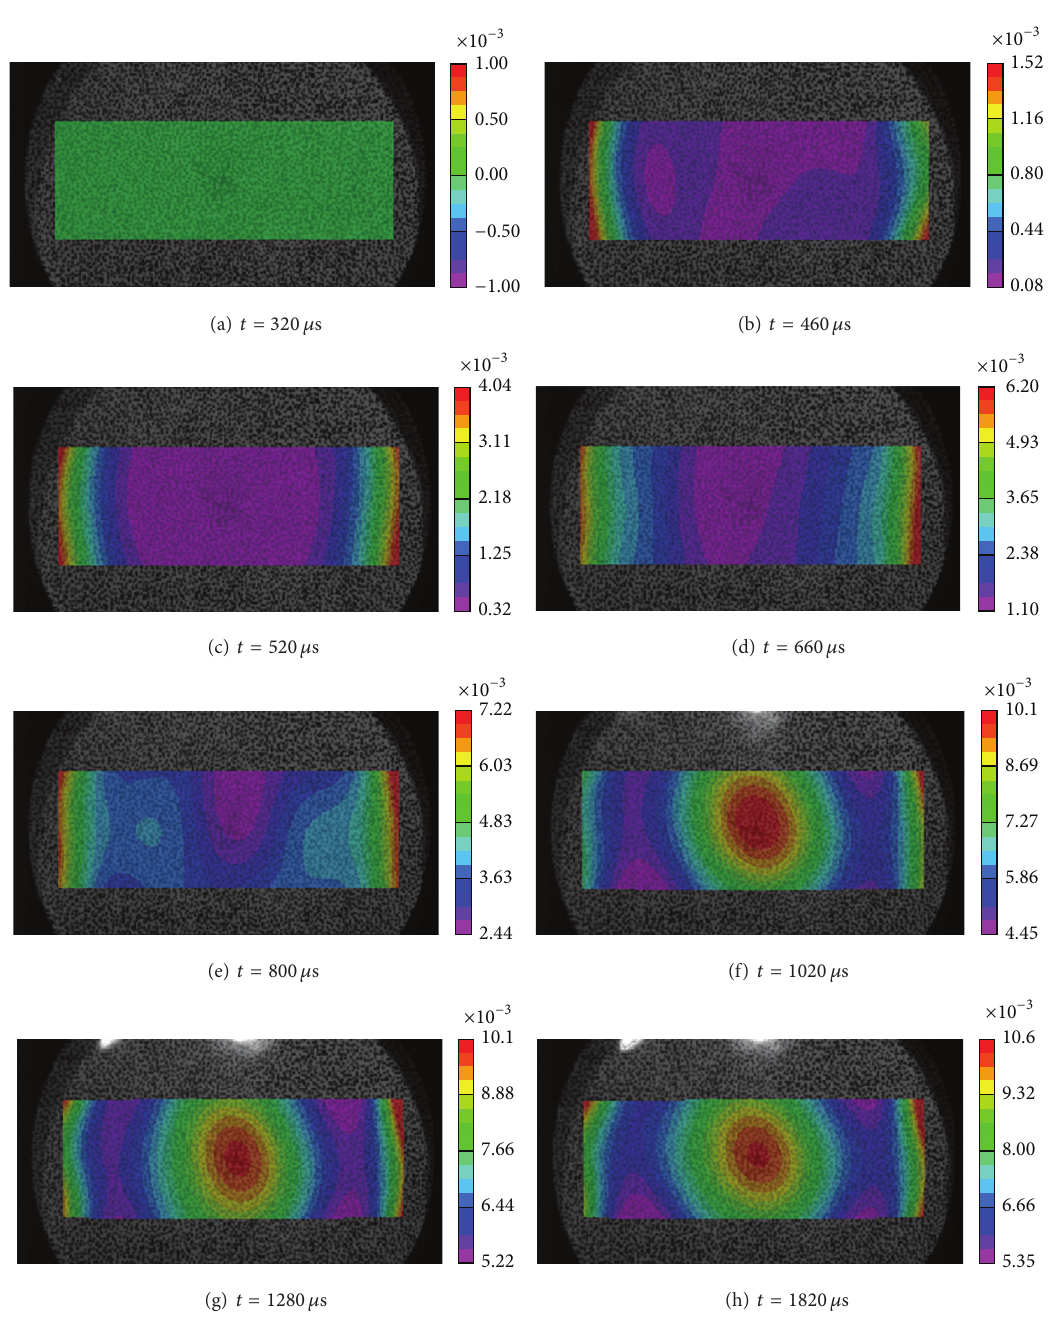
Figure 9: True strain field 𝐸 𝑥𝑥 at different time